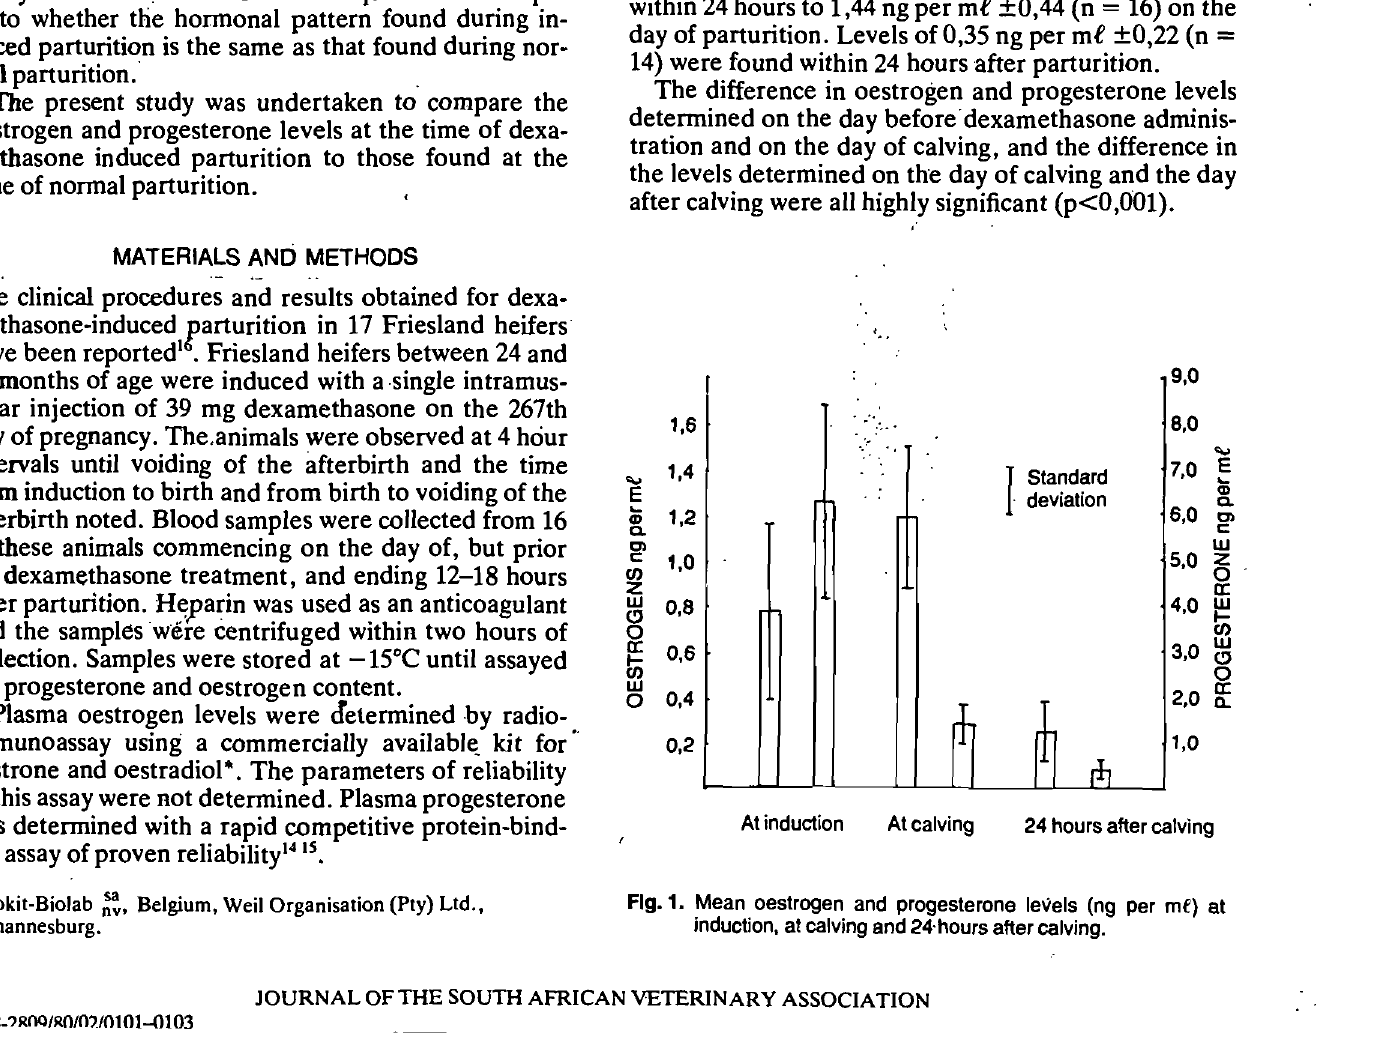
JOURNAL OF THE SOUTH AFRICAN VETERINARY ASSOCIATION M":!.R_?ROQ/RO/O?Jot ot"{)l